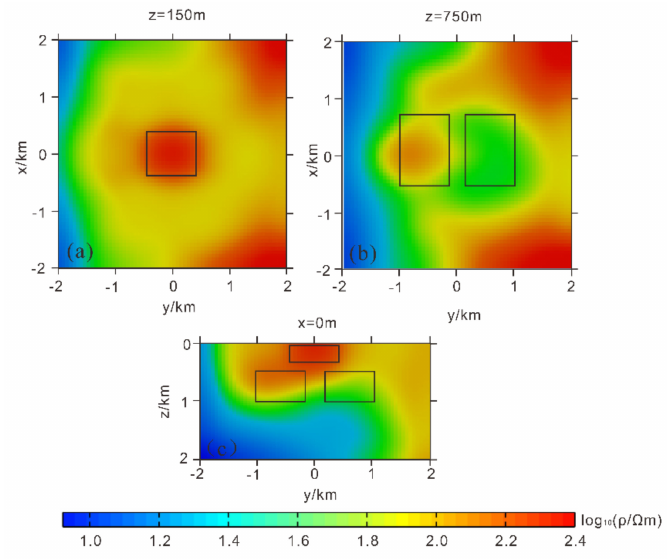
Figure 8. Inversion result yielded by the GD algorithm. ( a ) Horizontal sectional view at z = 150 m. ( b ) Horizontal sectional view at z = 750 m. ( c ) Vertical sectional view at x = 0